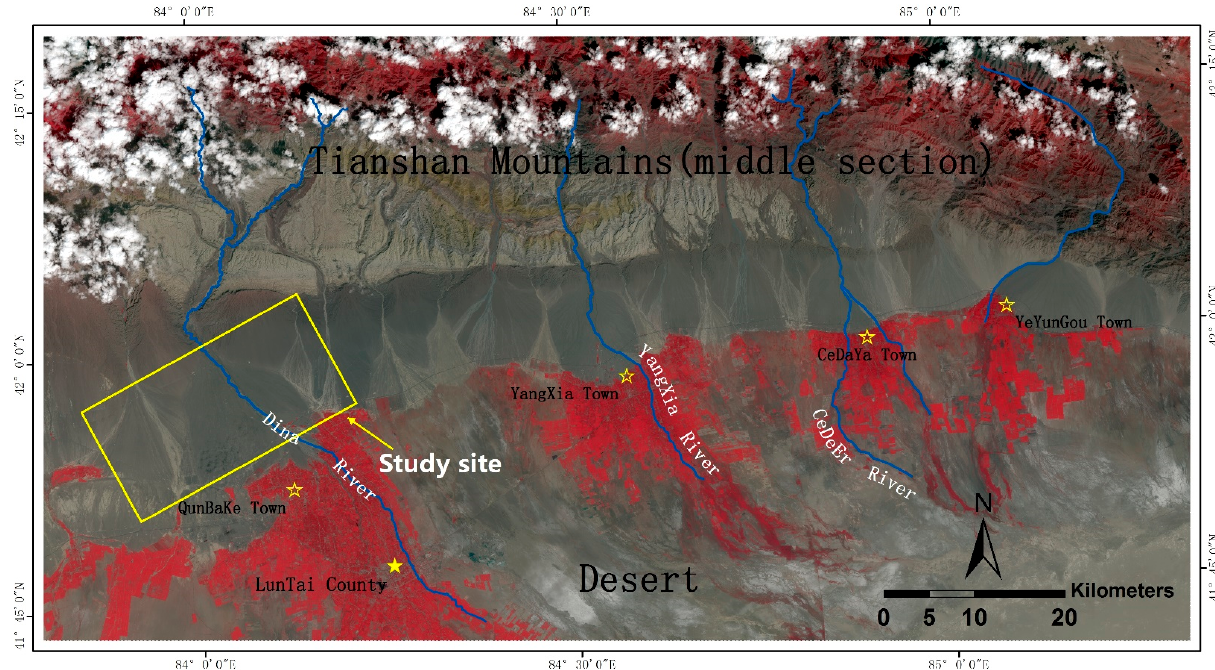
Figure 1. Location of the study area (yellow rectangle) in the Gobi region. The backdrop is a Landsat-8 satellite image.